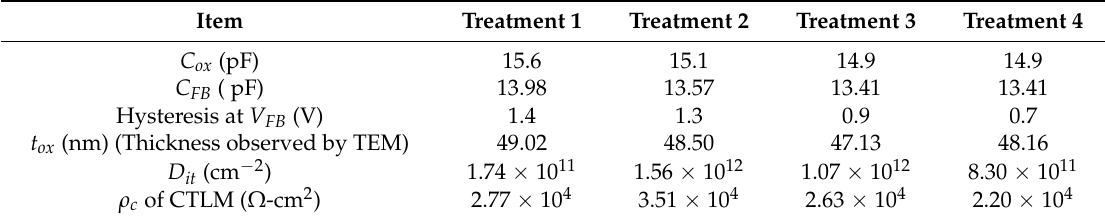
Table 2. The C ox , V FB , hysteresis at V FB , and D it of an MOS capacitor after different chemical treatments and the specific contact resistance ( ρ c ) of GaN contacted with